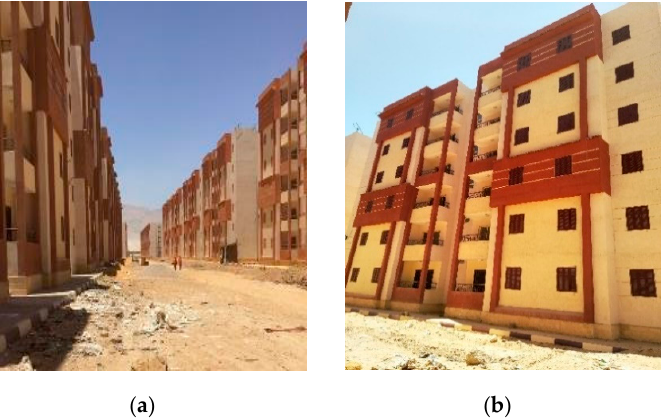
Figure 2. Pictures from the project site; ( a ) A picture showing the scale of the project; ( b ) A picture showing the East façade of a typical building.